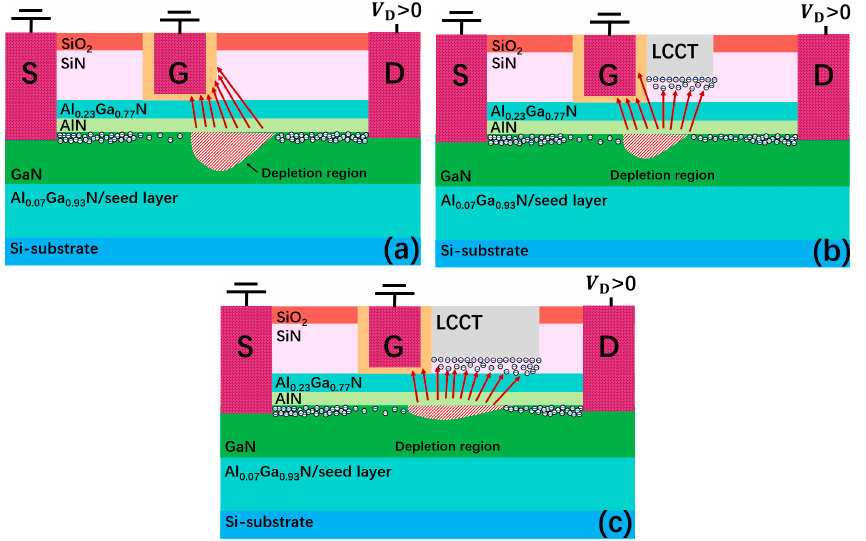
Figure 3. The schematic charges and electric field distribution of ( a ) conventional ultra-thin barrier HEMT (UTB-HEMT), ( b ) LCCT-HEMT with a short LCCT, and ( c ) LCCT-HEMT with a longer and deeper LCCT (red arrow represents electric field).